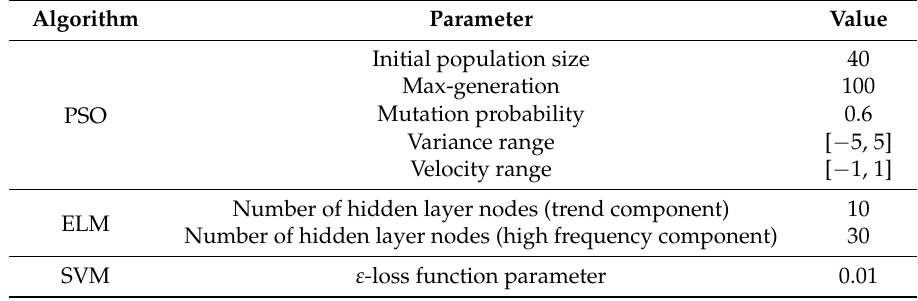
Table 6. The parameter setting of the algorithm.